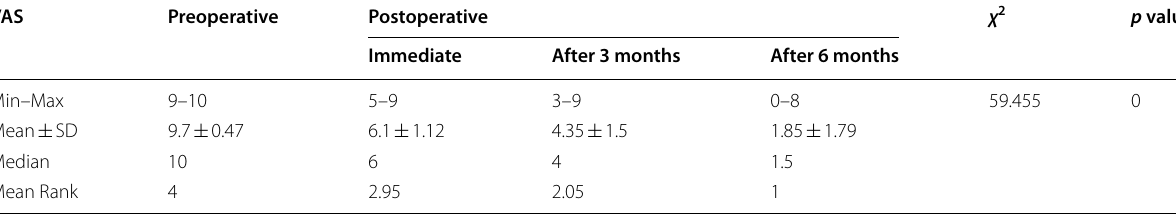
χ 2 Friedman test =